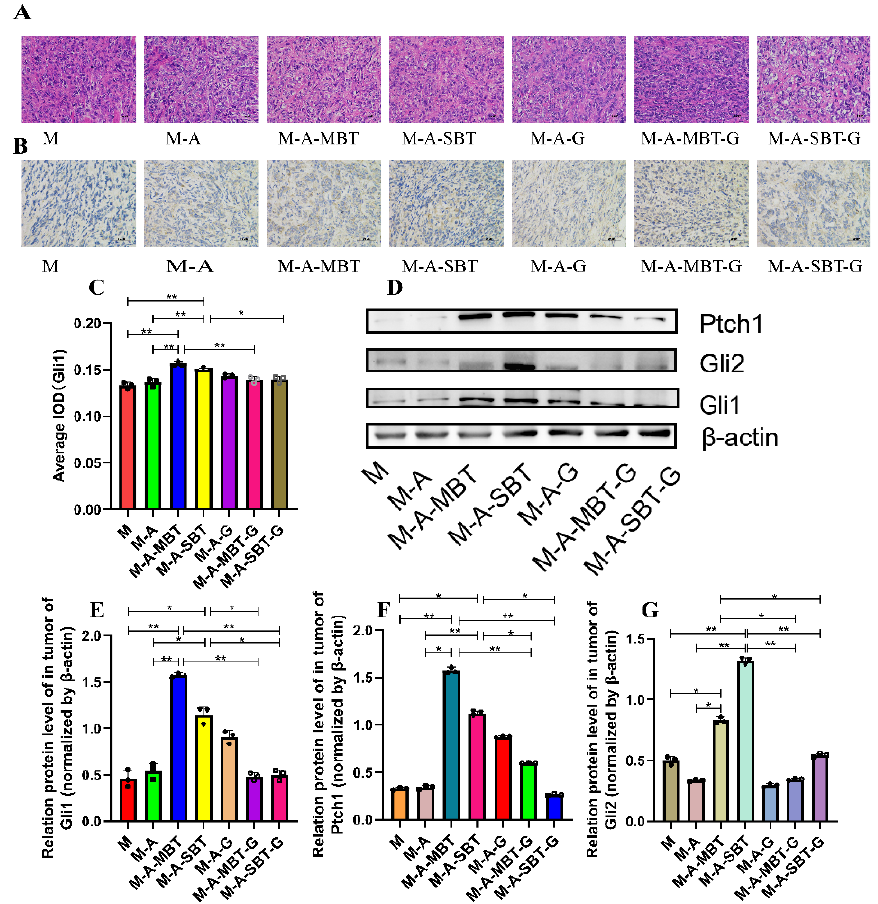
Figure 6. Suppression of Hh signalling proved that P . acnes promotes EOC progression in mice by regulating the Hh signalling pathway. ( A ) H&E staining images of tumour tissues were presented; bar regulating the Hh signalling pathway. (A) H&E staining images of tumour tissues were presented; bar represents 50µm. (B) Immunohistochemistry of Gli1 expression was determined in ovarian can ‐ represents 50 µ m. ( B ) Immunohistochemistry of Gli1 expression was determined in ovarian cancer of cer of mice; the bar represents 50µm. (C) Average integrated optical density (IOD) value of Gli1 mice; the bar represents 50 µ m. ( C ) Average integrated optical density (IOD) value of Gli1 expression expression in each group of tumour specimens. (D) Western blot analysis of Ptch1, Gli1, and Gli2 in each group of tumour specimens. ( D ) Western blot analysis of Ptch1, Gli1, and Gli2 expression in expression in tumour tissues; β‐ actin was used as an internal control (n = 3). The relative expressions tumour tissues; β -actin was used as an internal control (n = 3). The relative expressions of ( E ) Ptch1, of (E) Ptch1, (F) Gli1, and (G) Gli2 were quantified by Image J. Data are presented as means ± SD. ( F ) Gli1, and ( G ) Gli2 were quantified by Image J. Data are presented as means ± SD. Two-way Two ‐ way repeated ‐ measures ANOVA, both with Tukey ʹ s test for multiple comparisons, and the repeated-measures ANOVA, both with Tukey’s test for multiple comparisons, and the Log-rank test Log ‐ rank test were performed for survival data; * p < 0 .05, ** p < 0.01. ( H ) Smo, ( I ) Ptch1, ( J ) Gli1, were performed for survival data; * p < 0.05, ** p < 0.01. ( H ) Smo, ( I ) Ptch1, ( J ) Gli1, and ( K ) and ( K ) Gli2.